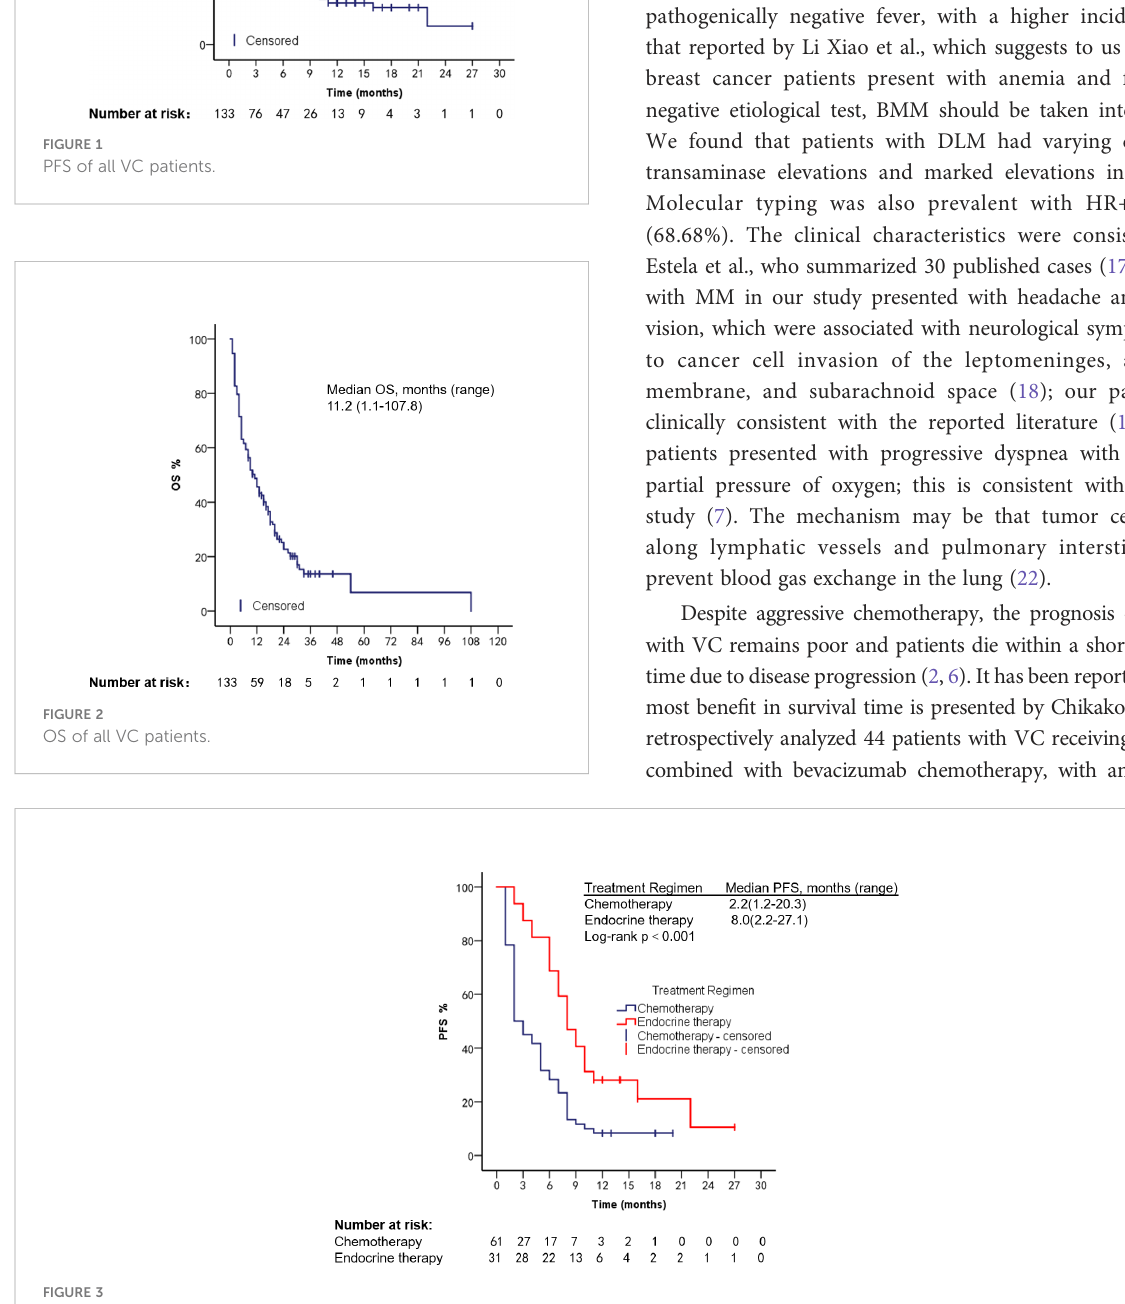
FIGURE 3 PFS of patients with different types of